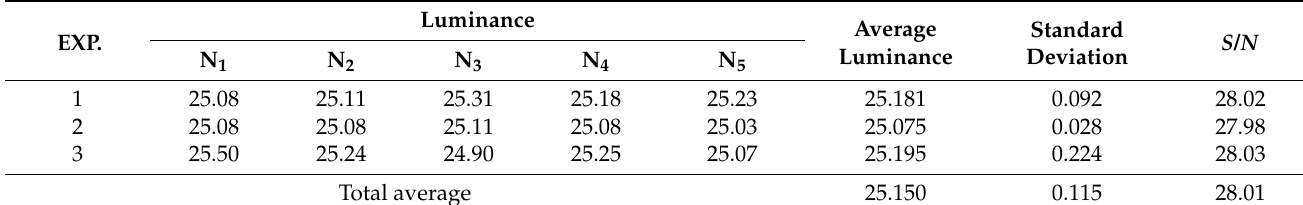
Table 18. Confirmation experiments for the genetic algorithm.